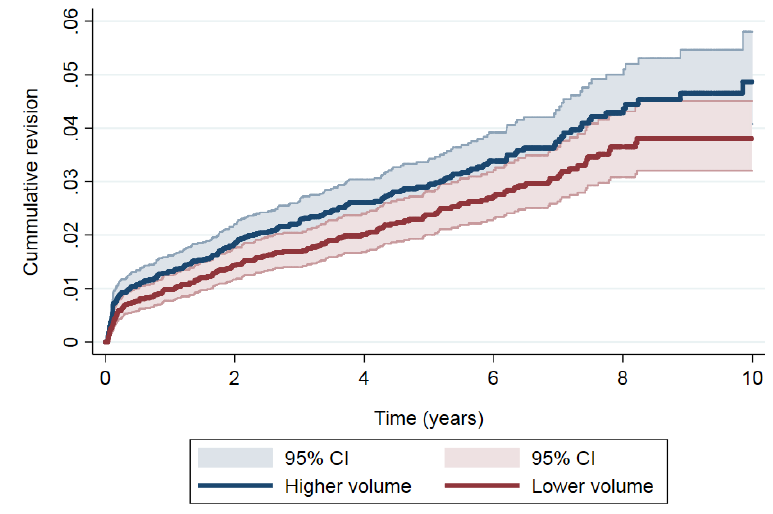
Figure 3. Cumulative revision in total hip arthroplasty (THA).